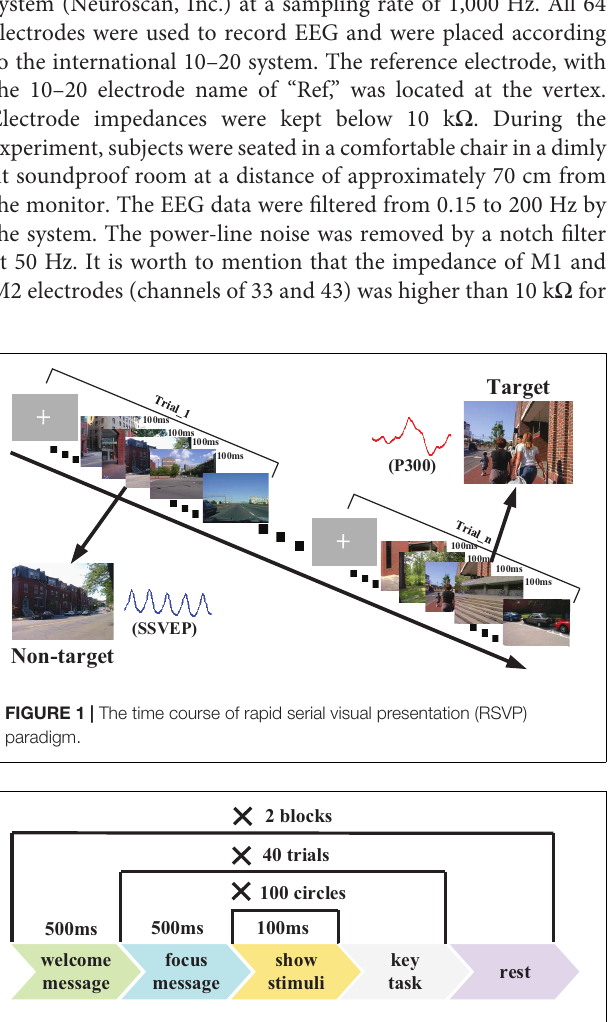
FIGURE 2 | The parameter settings of the experiment for each